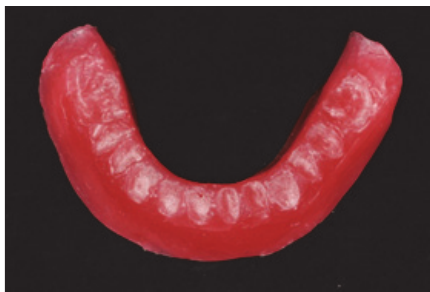
Figure 8: Wax denture base with the denture teeth